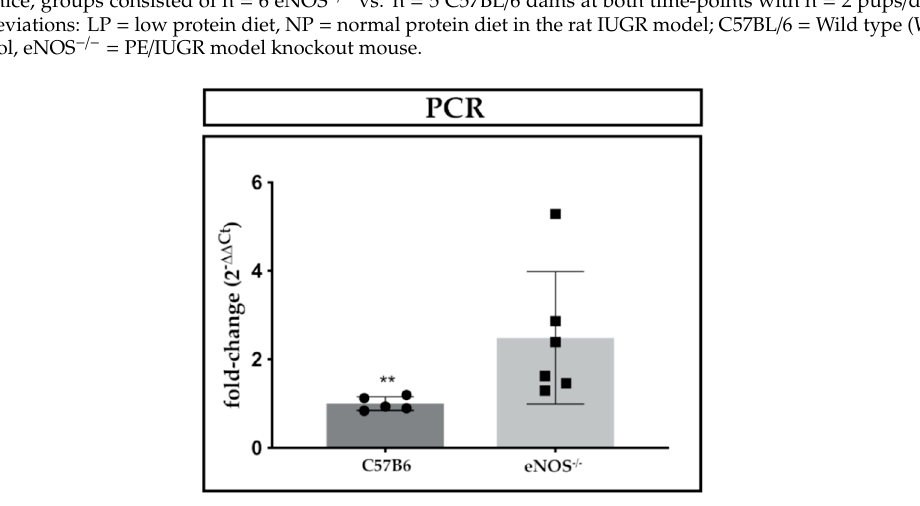
Figure 3. Placental IL-11 mRNA expression in eNOS -/- mice on E15. (** p = 0.004, Mann-Whitney U - test, WT: n = 5 dams, eNOS -/- : n = 6 dams with 2 pups each) Abbreviations: C57B6 = C57BL/6 wild type (WT) control strain, eNOS -/- = PE/IUGR model knockout mouse.